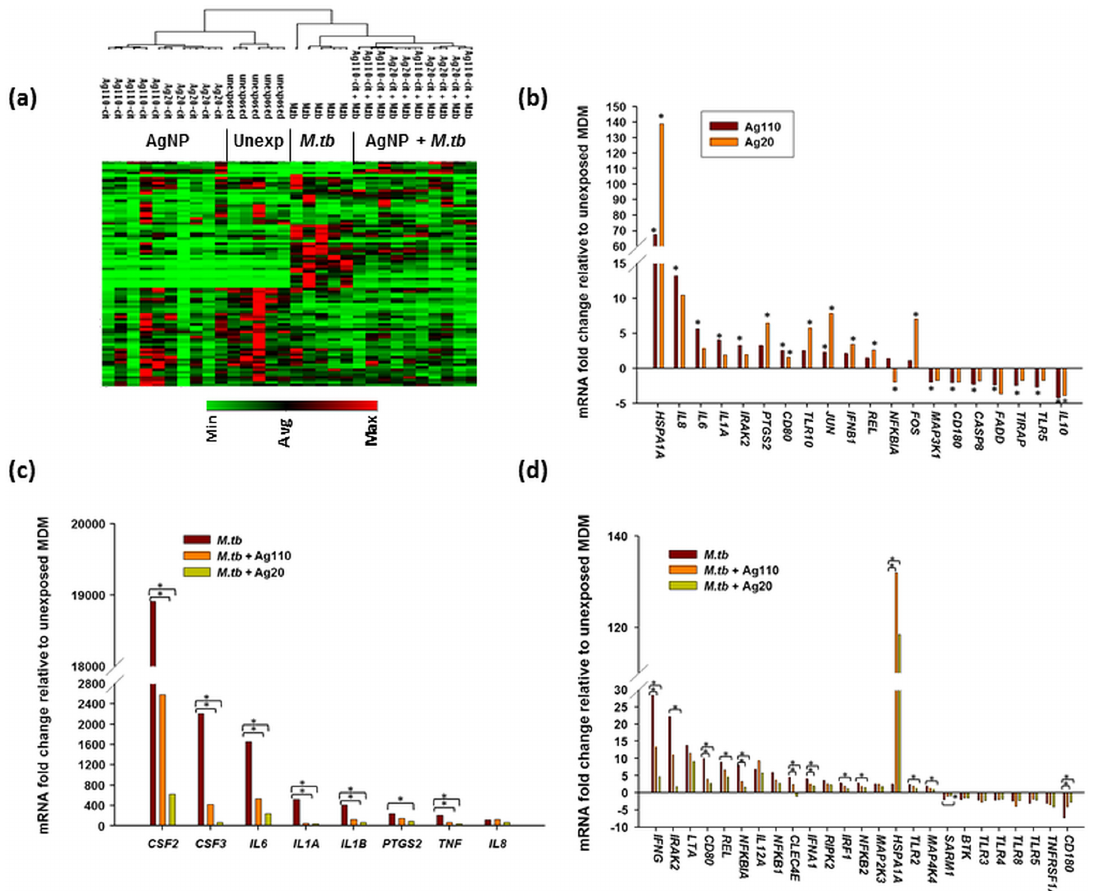
Fig 9. Comparison of AgNP-induced TLR signaling pathway-specific gene expression in MDM in the absence and presence of M . tb . MDM from five donors were exposed to Ag20-citrate ± M . tb , Ag110-citrate ± M . tb , M . tb , or left unexposed for 4 hours at 37°C in a humidified 5% CO 2 environment followed by RNA extraction. The final concentration of AgNP was 10 μ g/mL and M . tb was used at a MOI 10. RNA was analyzed by TLR pathway specific RT 2 profiler arrays (Cat. No. PAHS 018E, Qiagen Sciences, MD) [28]. Levels of cDNA were calculated with the relative quantitation method ( ΔΔ C t method) from the PCR array data using analysis software accessed from http://sabiosciences.com/pcrarraydataanalysis.php. Statistical differences in fold-mRNA expression levels between AgNP-exposed and unexposed and uninfected cells were calculated using the same software. ( a ) Non-supervised clustering of the entire dataset showing the overall pattern of expression of 84 genes across 30 MDM samples from five human subjects with each row and column representing a gene and samples, respectively. A dendrogram including all 30 samples are shown. ( b ) Mean fold-changes ( (cid:1) 2-fold) of mRNA from MDM exposed to 10 μ g/mL of Ag20-citrate or Ag110-citrate relative to unexposed MDM are shown. Statistically significant changes ( p < 0.05) relative to AgNP-unexposed MDM are marked by an asterisk ( * ). ( c ) and ( d ) M . tb -induced alteration of mRNA expression with mean fold-changes (cid:1) 2-fold and p (cid:3) 0.05 relative to uninfected MDM were compared with that from MDM treated with M . tb + Ag20-citrate or M . tb + Ag110-citrate. Panel c shows mRNA fold-changes induced by M . tb alone that are (cid:1) 100-fold and panel d shows mRNA fold-changes induced by M . tb alone that are < 100-fold. Statistically significant changes ( p < 0.05) relative to M . tb - induced expression are marked by an asterisk ( *